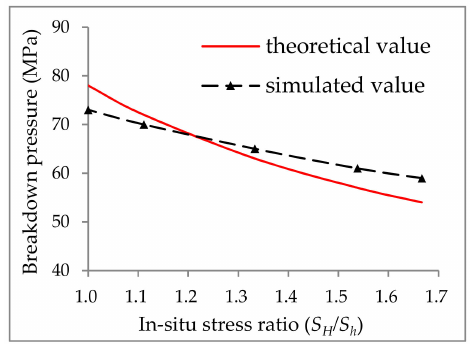
Figure 6. Breakdown pressures obtained from simulated values and the theoretical values calculated according to Equation (6).